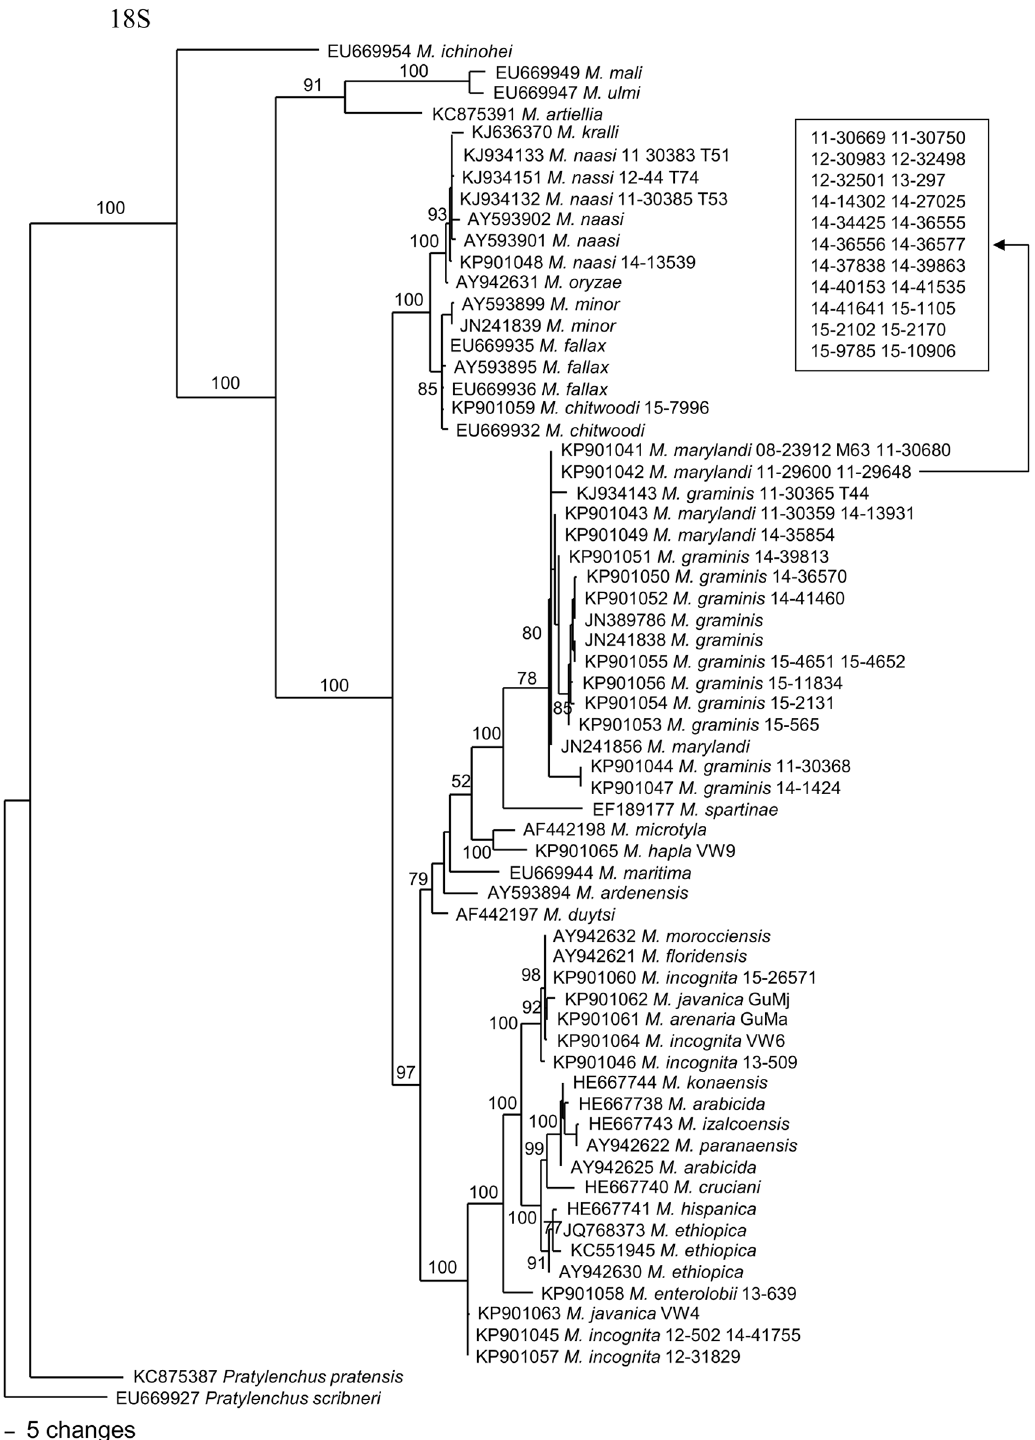
Fig 2. The 10001st Bayesian tree inferred from 18S under GTR+I+G model (-lnL = 7750.8096; AIC = 15521.6191; freqA = 0.2618; freqC = 0.2096; freqG = 0.2649; freqT = 0.2638; R(a) = 1.6485; R(b) = 3.5003; R(c) = 2.7135; R(d) = 0.5616; R(e) = 5.9174; R(f) = 1; Pinvar = 0.5043; Shape = 0.5848). Posterior probability values exceeding 50% are given on appropriate